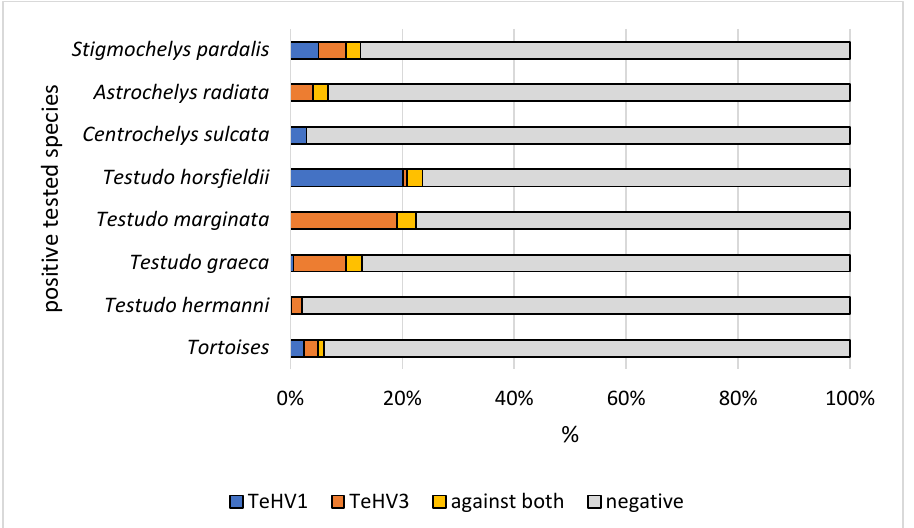
Figure 1. Herpesvirus (TeHV1 and TeHV3) antibody detection rates (titer 2 or higher) of the positive tested species (Hermann’s tortoises, Testudo hermanni ; spur-thighed tortoises , Testudo graeca ; marginated tortoises, Testudo marginata ; Russian tortoises, Testudo horsfieldii ; African spurred tortoise, Centrochelys sulcata ; radiated tortoise, Astrochelys radiata ; and leopard tortoise, Stigmochelys pardalis ).